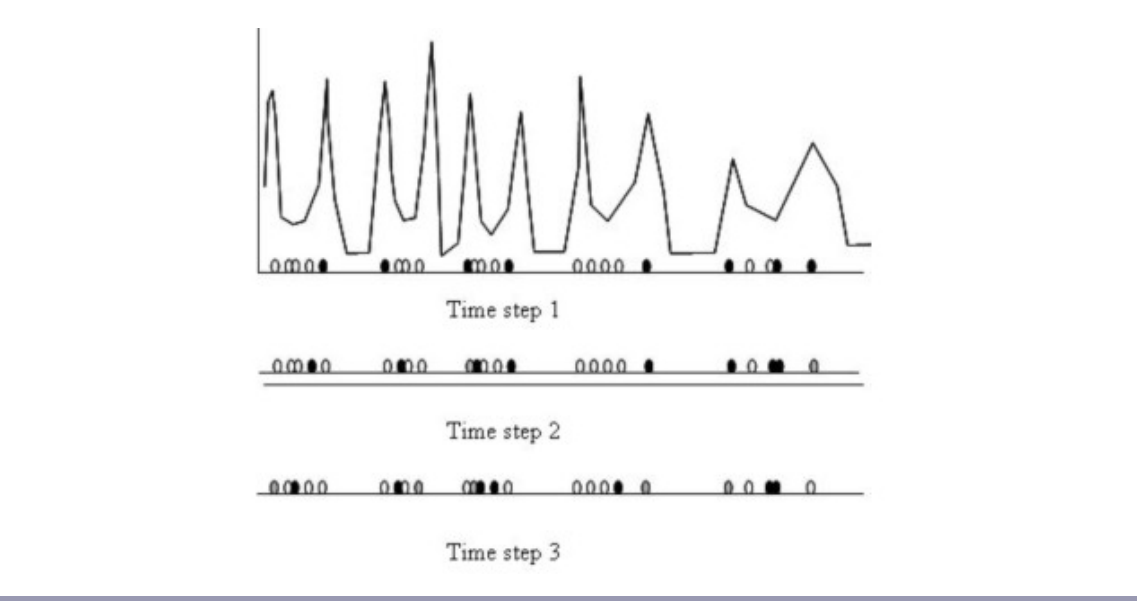
Fig. 6 . The novelty cycle in discontinuous panarchical systems is analogous to the taxon cycle described by Wilson (1961). Variability in resources (line above the x axis that represents the discontinuous body mass distribution of species) is highest at scale breaks, as in Figure 5. In time step one, novel behaviors or species (black) are added at scale breaks. As time progresses (time step two) the novel behaviors or species have ‘migrated’ towards the center of body mass aggregations where resources are less variable. By step three, this migration has completed. In time steps two and three new novelty is being introduced at the edges (grey). This diagram does not show the increased extinction rates also expected to be associated with scale